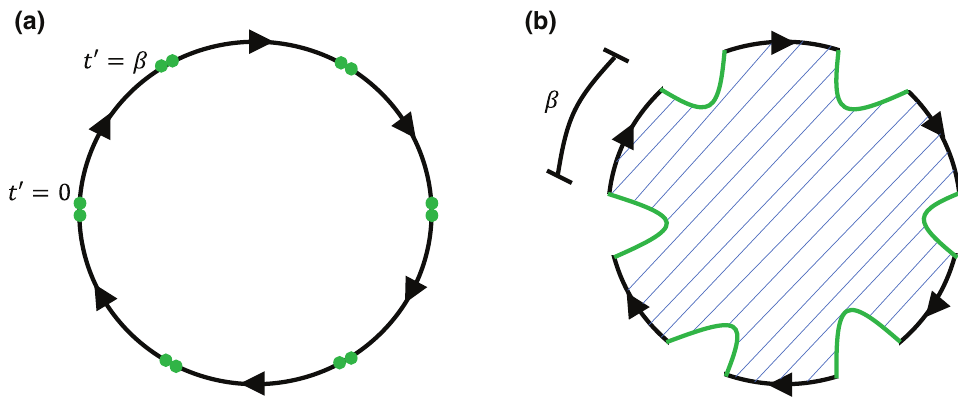
(cid:16) (cid:17) m can be represented as in (a) for n = 6. The Euclidean path integral = Tr FIG. 12. Boundary path integrals for Z ( B ) f ( H B ) e − β H B B m along each black line from t (cid:8) = 0 to t (cid:8) = β represents e − β H B , and each green dot represents f 1 2 ( H B ) . For convenience of presentation we arrange the factor f ( H B ) symmetrically in each replica. (b) The dual gravity description of the boundary path integral, where one should integrate over all bulk configurations with the specified boundary topology, and we interpret the green dots representing f ( H B ) as the end-of-the-world